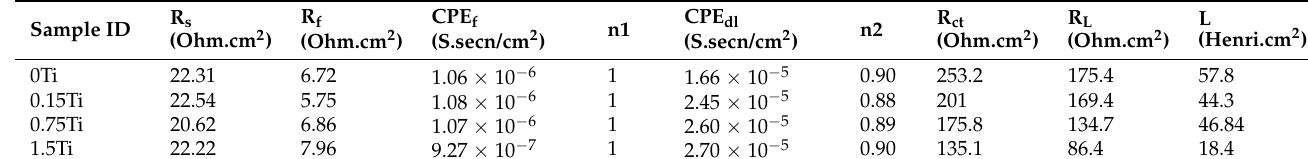
Figure 11. The electrical equivalent circuit utilized to fit the EIS experimental data. Table 2. The values of elements in the equivalent circuit shown in Figure 11.